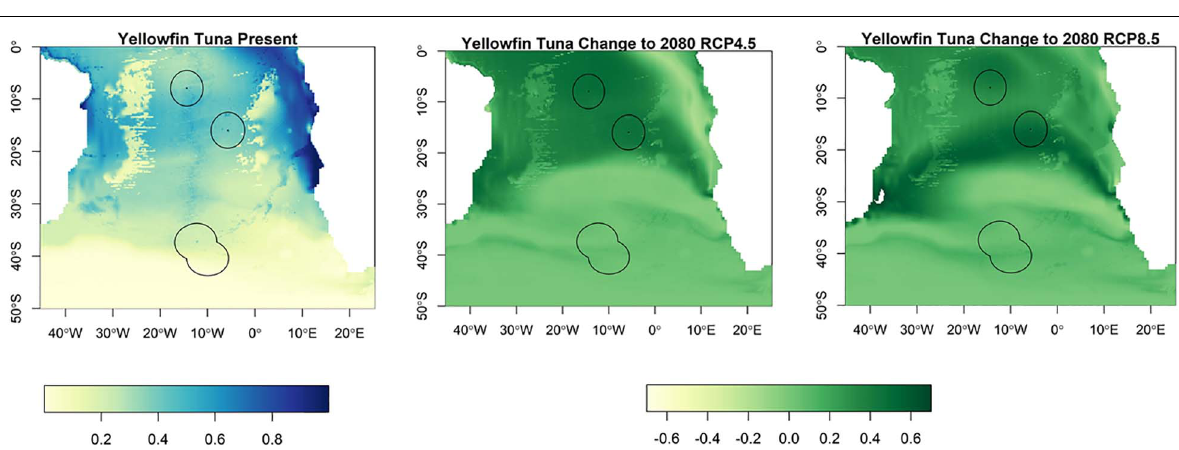
FIGURE 5 | The habitat suitability for yellowfin tuna from Maxent in the South Atlantic for the present day and the change to 2080 under RCP4.5 and RCP8.5. The EEZs are shown in the black outline. The yellow areas are the most suitable, and the dark blue the least